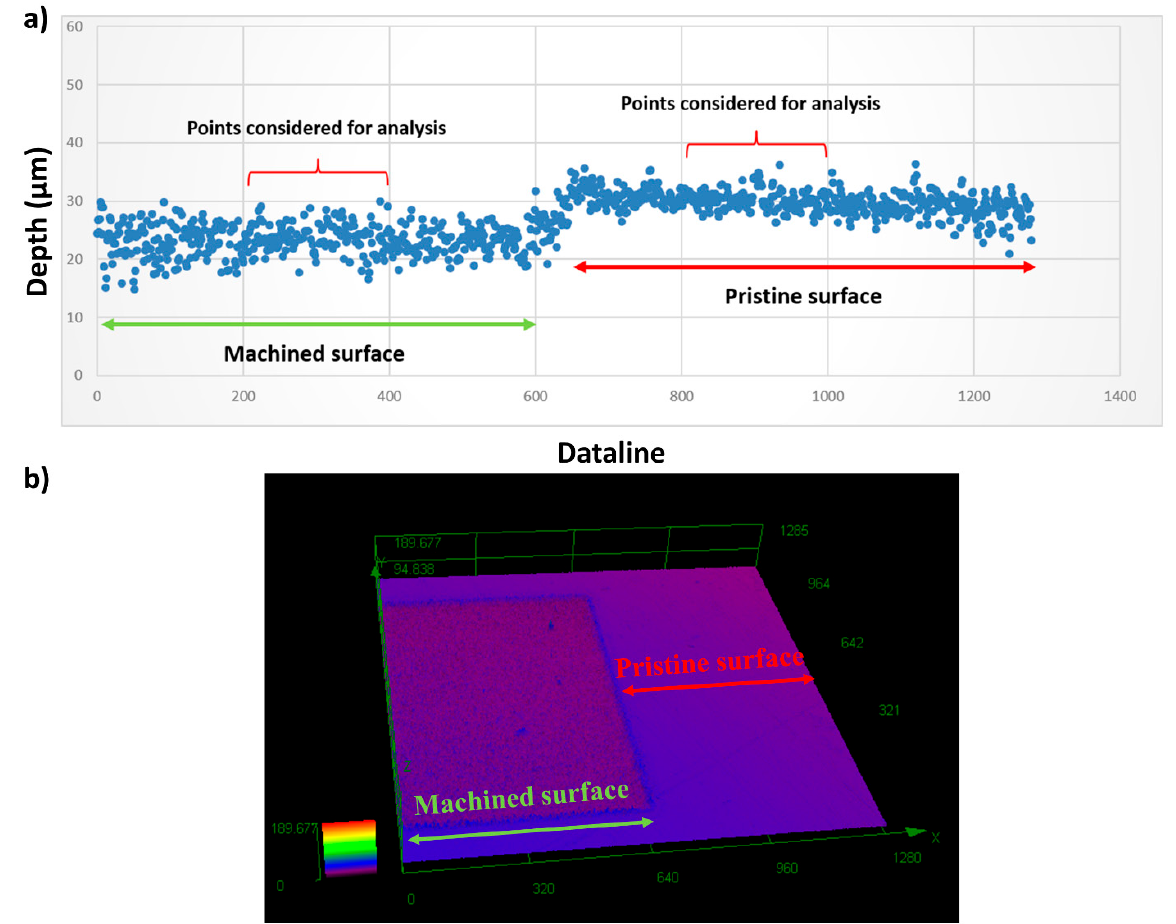
Figure 2. ( a ) Schematic of ablation depth measurement and ( b ) a typical 3D confocal image.